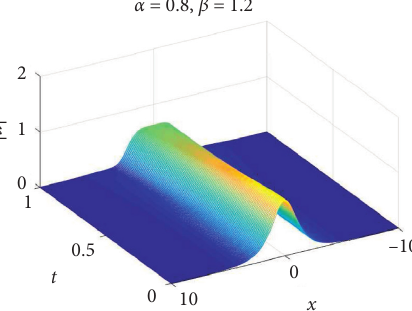
Figure 9: The trace of the solution to | u | of FCNLSE (32) with α � 0 . 8 and β � 1 . 2.